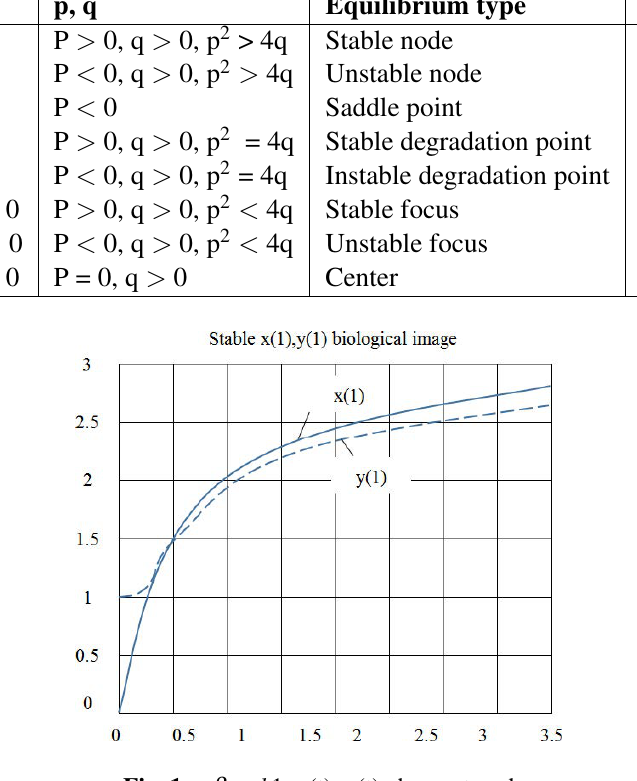
Fig. 1 αβ > k 1, x(t), y(t) change trend